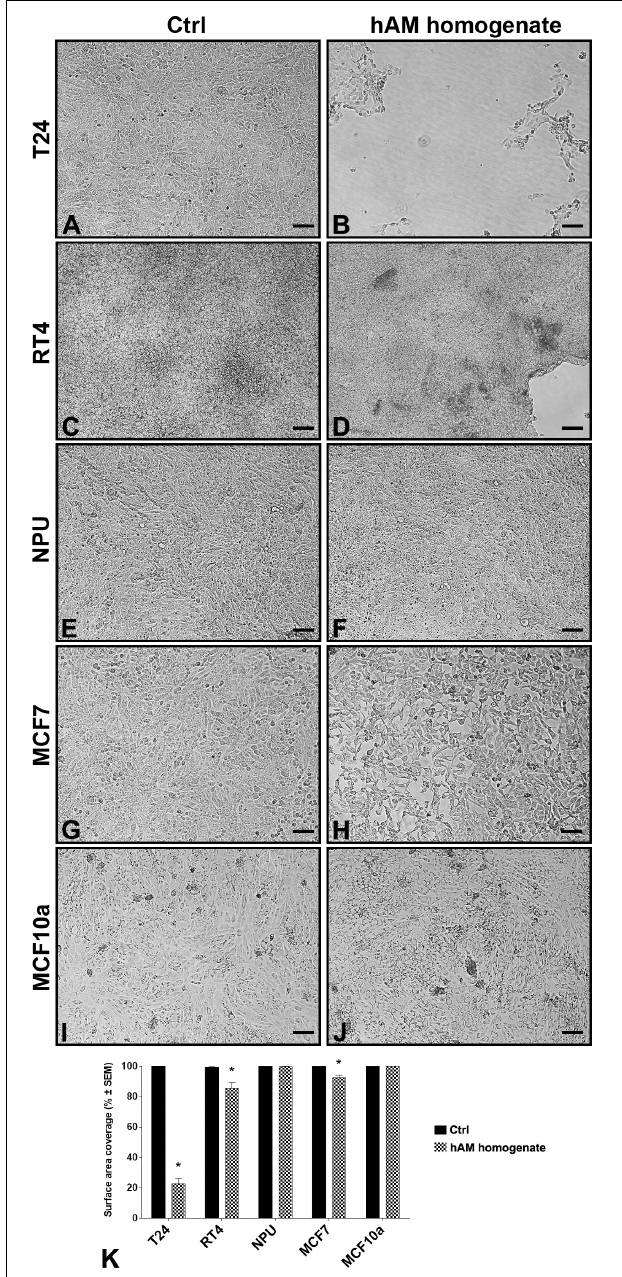
FIGURE 2 | Human amniotic membrane (hAM) homogenate causes detachment of various cancer cell types but not of normal cells. (A,C,E,G,I) After 24-h incubation with an appropriate culture medium without hAM homogenate, T24, RT4, NPU, MCF7, and MCF10a cells remained firmly attached to the culture surface. (B,D,H) 24-h incubation with hAM homogenate resulted in significant detachment of cancer T24, RT4, and MCF7 cells, (F,J) but not of normal NPU and MCF10a cells. The most presentative images are shown. (K) The percentage of surface area covered after 24-h treatment with hAM homogenate. The data are presented as mean surface area coverage ± SEM (SEM, the standard error of the mean). Data were obtained from three independent experiments, each performed with a different biological sample of hAM. Within each experiment, three technical replicates were performed. Scale bars: 100 µ m. * p <